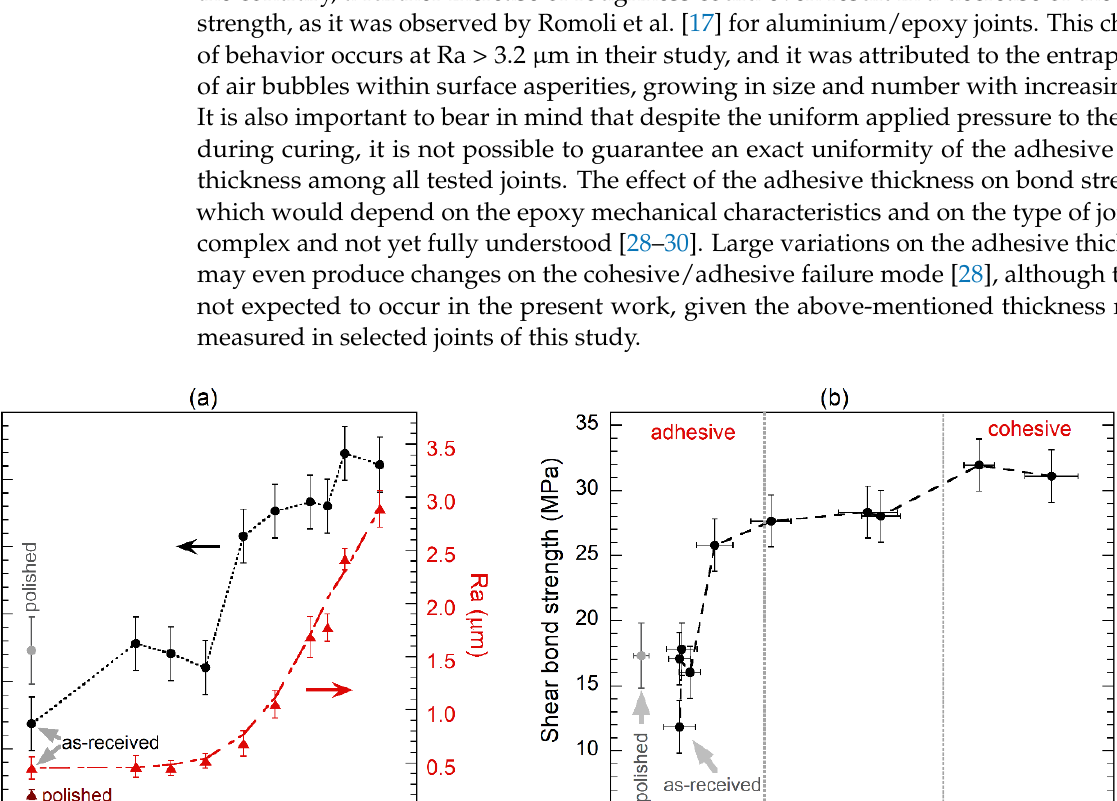
bond strength values were 17.0 ± 1.3 MPa (without thermal cycling) and 16.8 ± 1.5 MPa